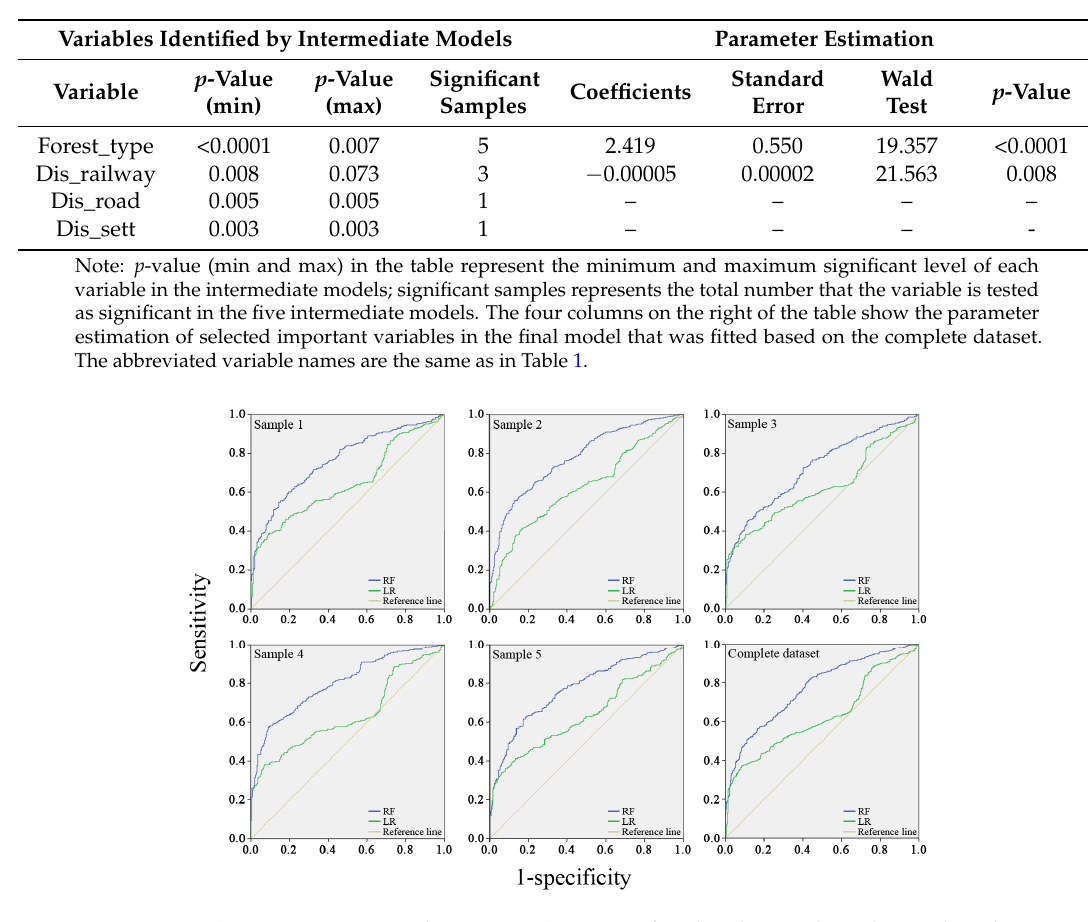
Table 3. Variables included in the final model using Random Forests, in descending order of importance based on mean decrease in accuracy from the complete data set.